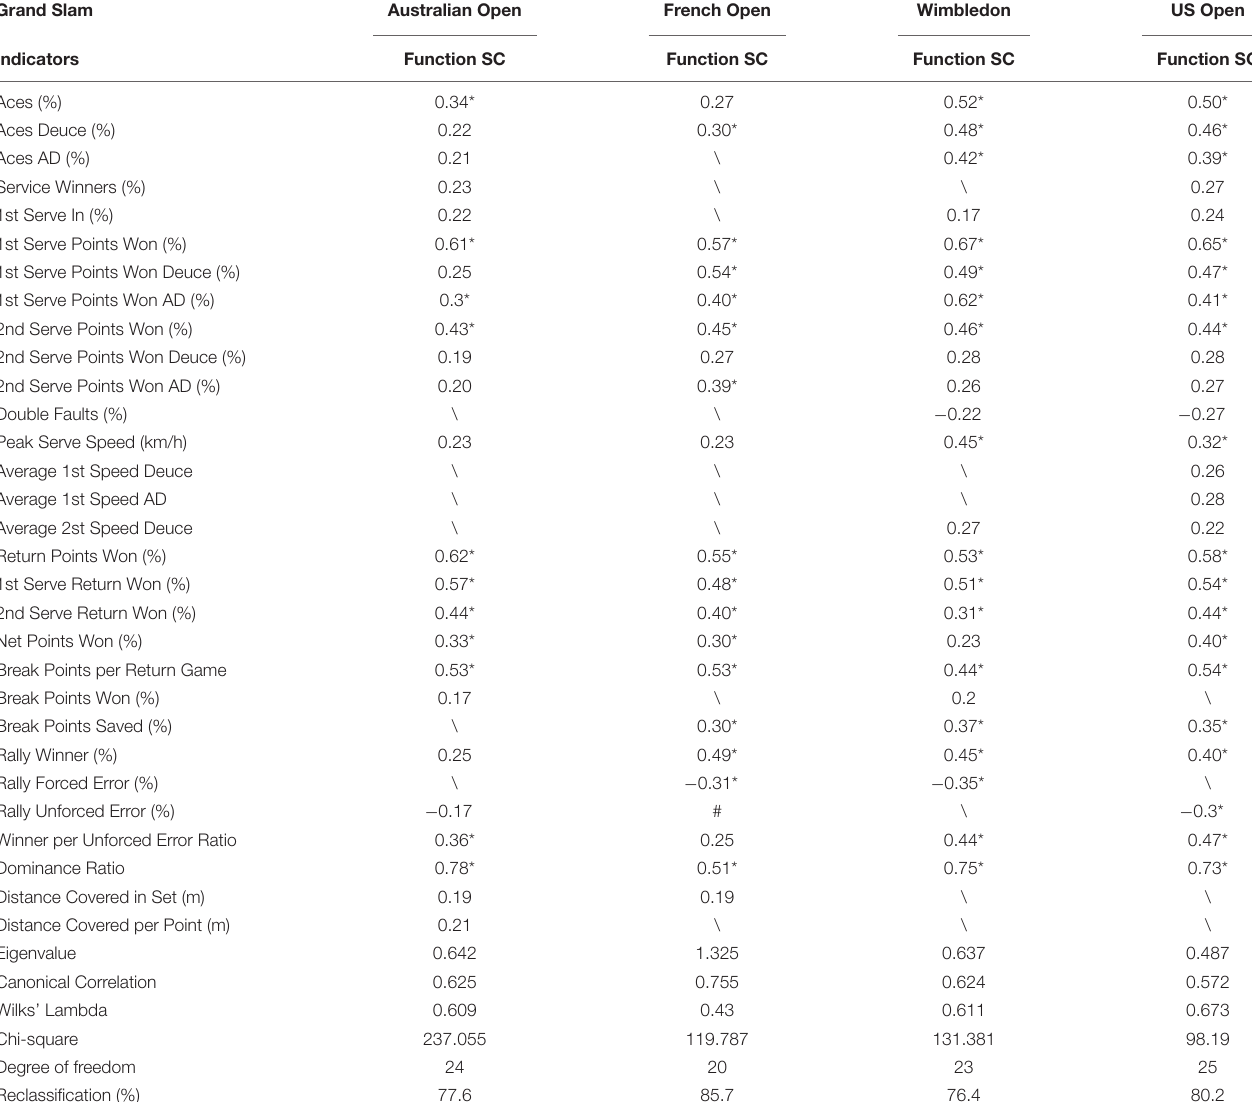
TABLE 5 | Results of discriminant analysis and structure coefficients of input indicators for Grand Slams. Grand